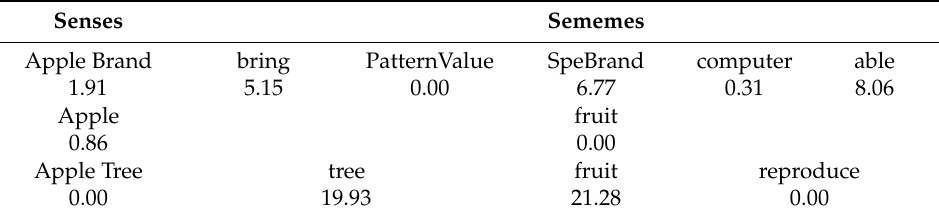
Table 5. “You can like apple ( Apple Brand) computers, just don’t vilify other brands.”